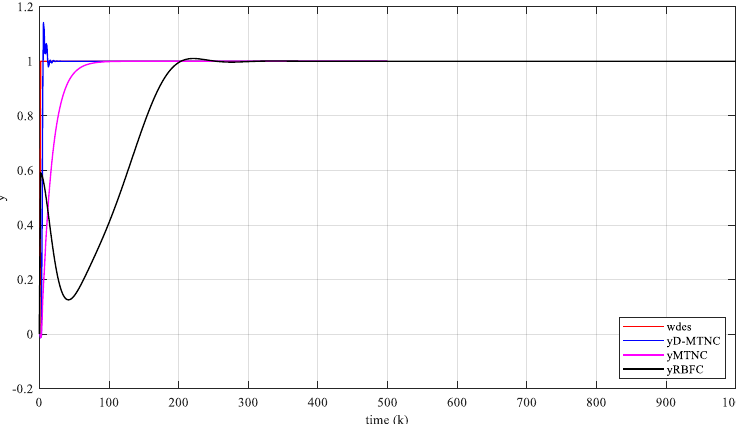
Figure 4. The tracking trajectory without noise.